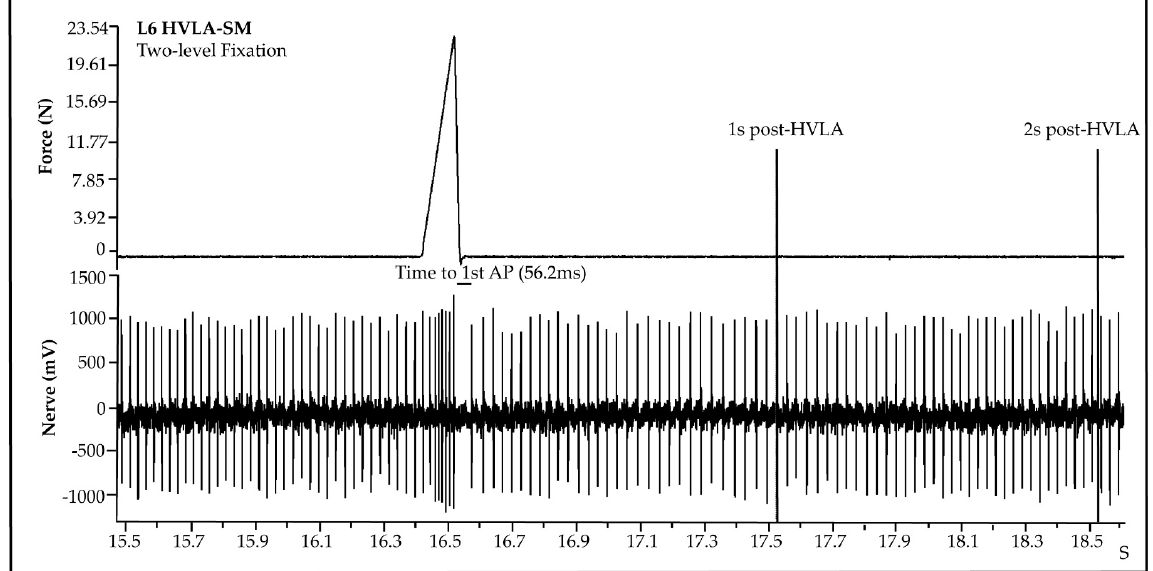
Figure 2. Post-HVLA-SM outcomes. A representative example of a raw muscle spindle recording of a simulated L6 HVLA-SM with a 100 ms thrust duration. Measured outcomes include time to 1st action potential (AP), and frequency discharge during 1 and 2 s post-HVLA-SM.